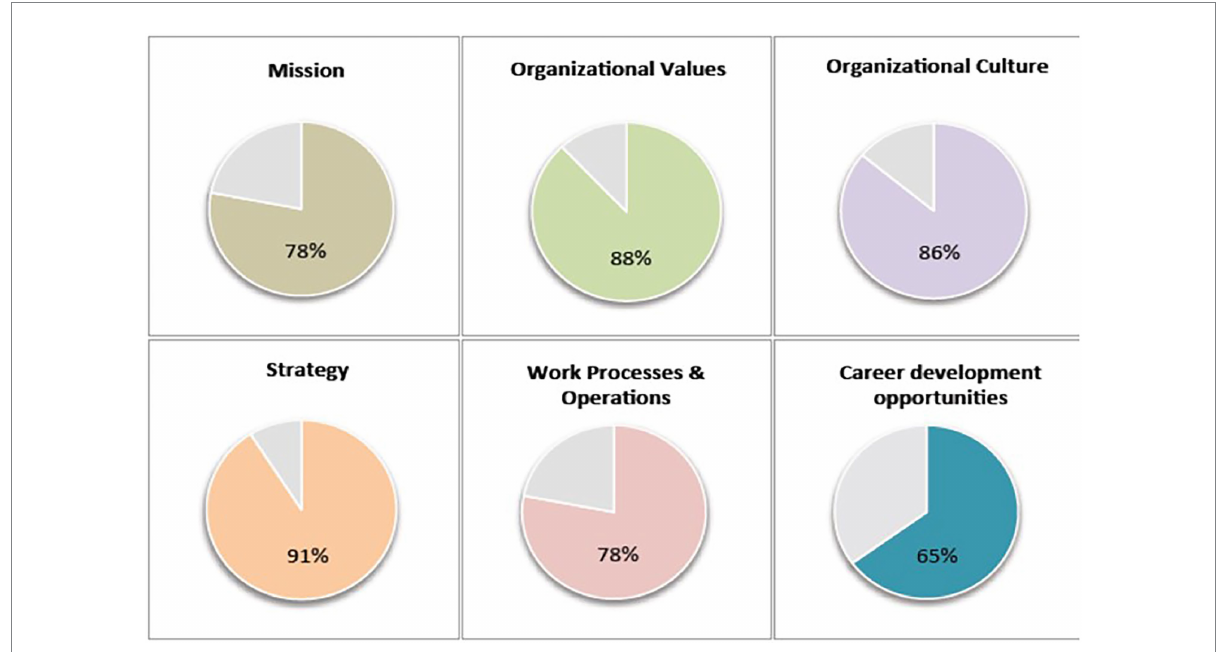
FIGURE 3 Team prototypicality manipulation (high team prototypicality condition) in Study